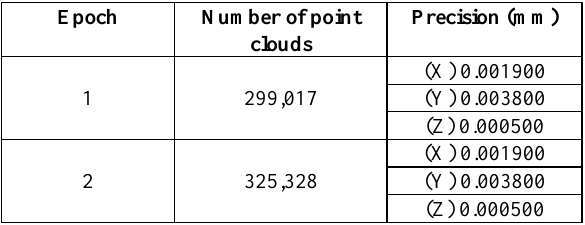
Table 3. Metadata for epoch 1 and epoch 2 mobile laser